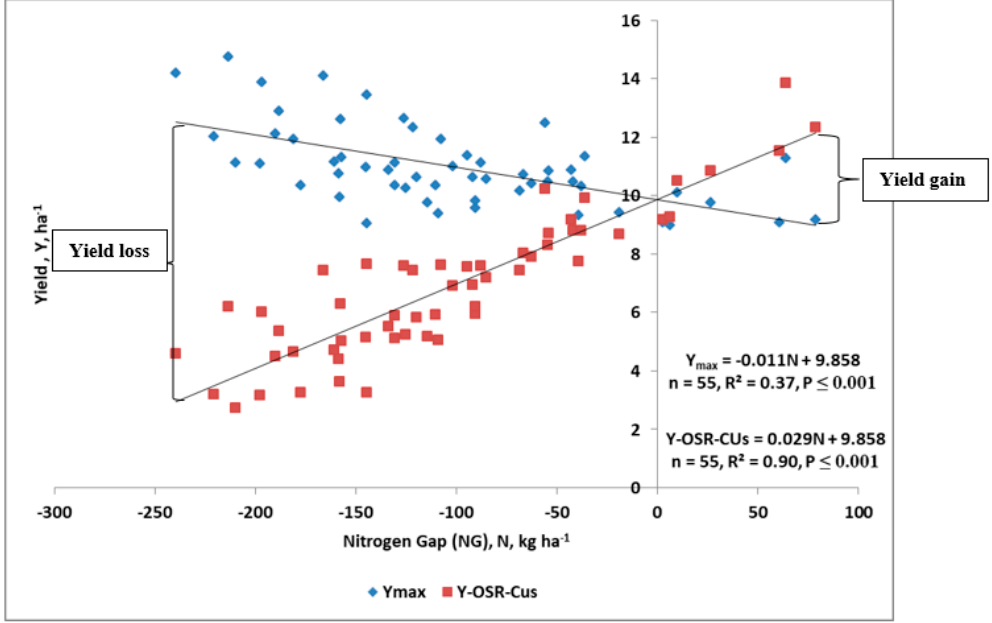
Figure 5. Trends in real and maximum attainable yields in response to nitrogen gap—WOSR. Figure5. Trendsinrealandmaximumattainableyieldsinresponsetonitrogengap—WOSR.Y-OSR-CUs, Y-OSR-CUs, Y max —real and maximum attainable yields of WOSR expressed in cereals units. Y max —real and maximum attainable yields of WOSR expressed in cereals